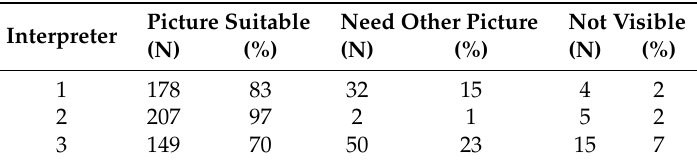
Table 8. Suitability of the collected street-level imagery for the photo-interpretation for each of the interpreters. Either the picture automatically selected is suitable for photo-interpretation, or the interpreter needs to select another picture of the same parcel, or the parcel is not visible from any of the collected pictures.